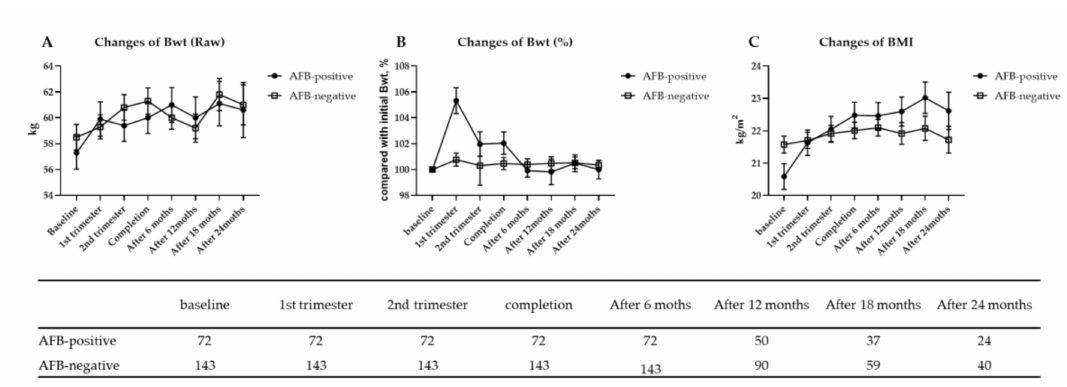
Figure 3. Changes from baseline in body weight ( A ), % change of body weight compared with baseline ( B ) body mass index ( C ) from the time of diagnosis to 2 years follow-up after treatment completion; the observed mean change from baseline over the period of anti-TB therapy in the AFB smear-positive and negative groups. Bwt, body weight; BMI, body mass index; AFB, acid-fast